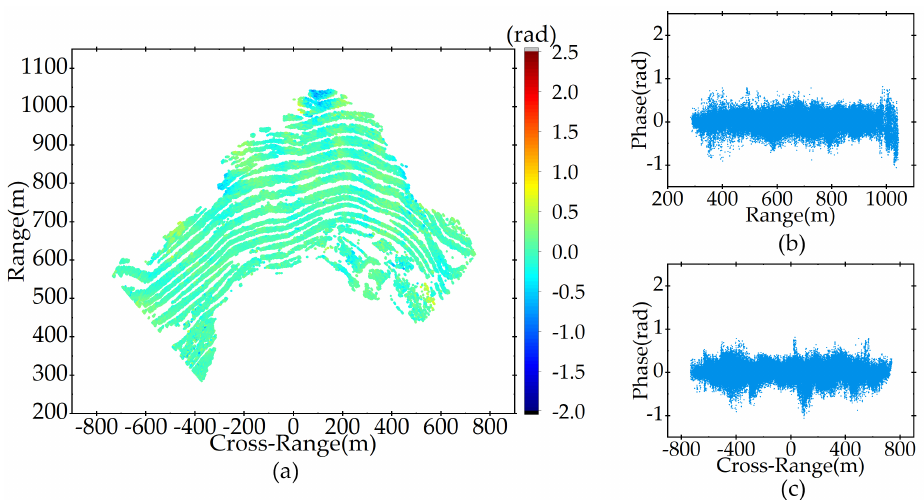
Figure 13. Corrected phase distribution of the 7th interferogram by the proposed method: ( a ) overall phase distribution, ( b ) phase distribution along the range direction, ( c ) phase distribution along the cross-range direction.